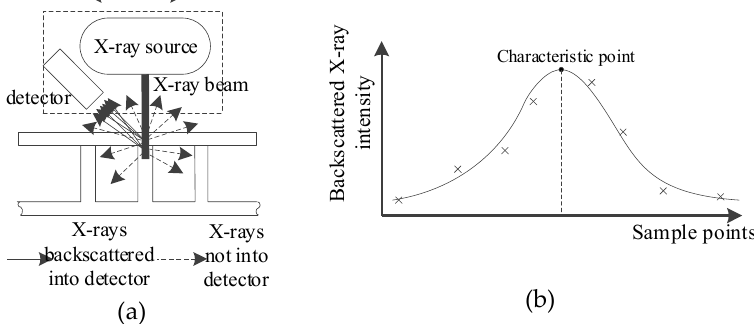
Figure 2. The scheme for X-ray scanning to locate the center of core panel: ( a ) the scheme for scanning; ( b ) the scheme to locate the core panel.